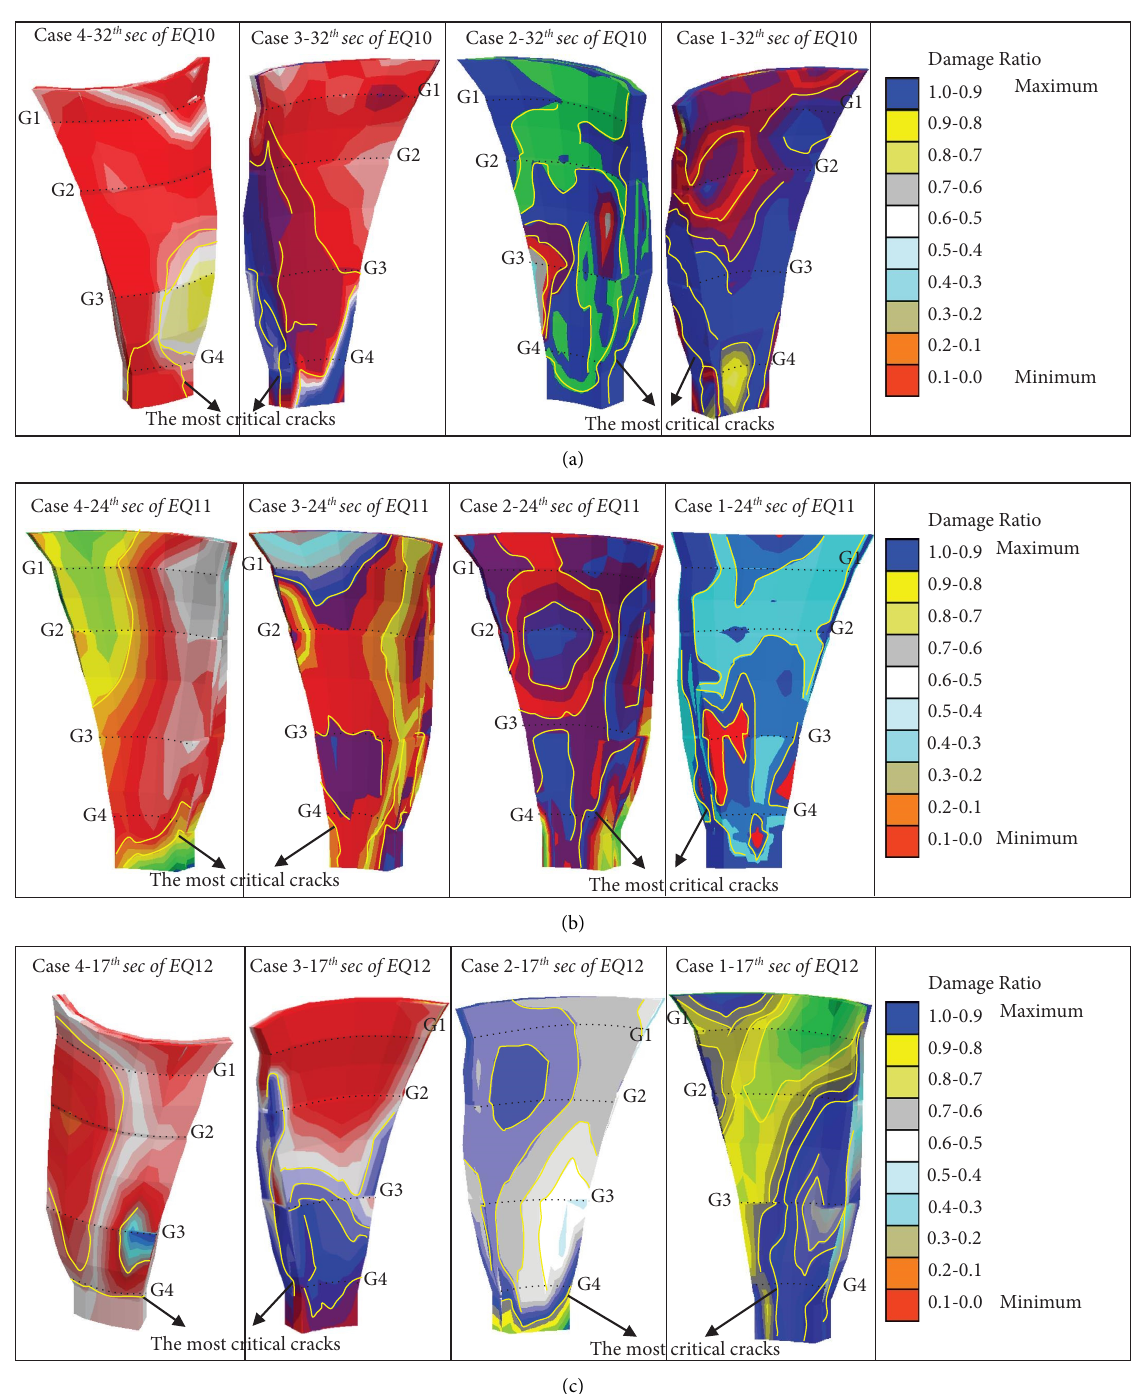
Figure 15: Earthquake crack performance of Ermenek arch dam for (a) EQ10 earthquake, (b) EQ11 earthquake, and (c) EQ12